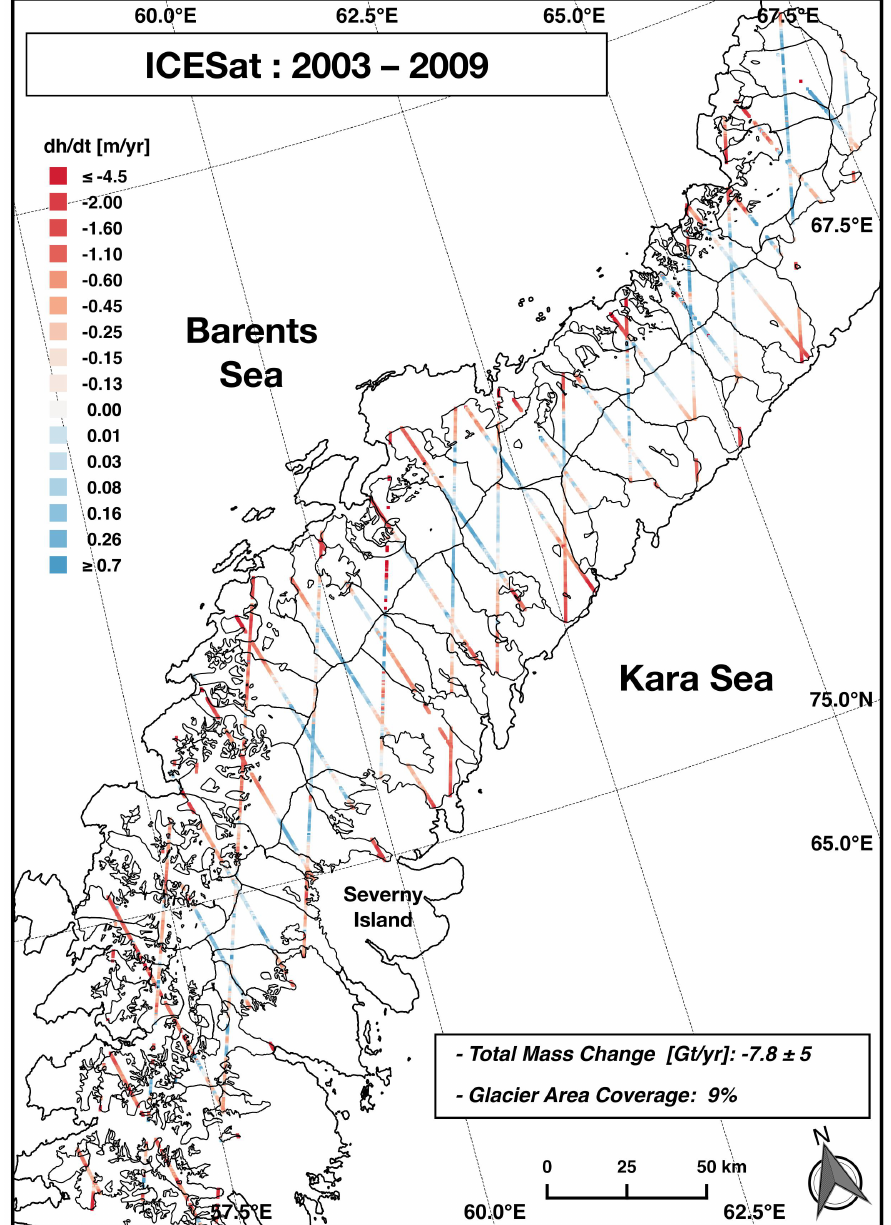
Figure 3. Map of ice elevation change for NZEM glaciers estimated using ICESat for October 2003 to October 2009. Regional glaciers outlines are extracted from the sixth release of the Randolph Glacier Inventory